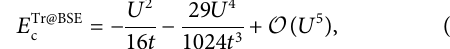
Frontiers in Chemistry |